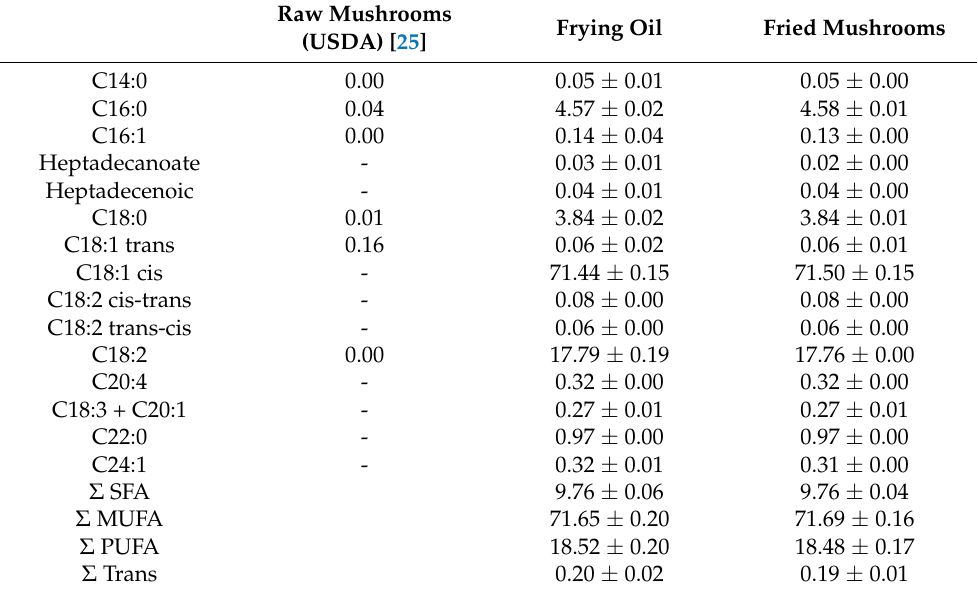
Table 2. Content of the main fatty acids (g/100 g FA) in frying oil and fried mushrooms. Raw Mushrooms Frying Oil Fried (USDA) [25]